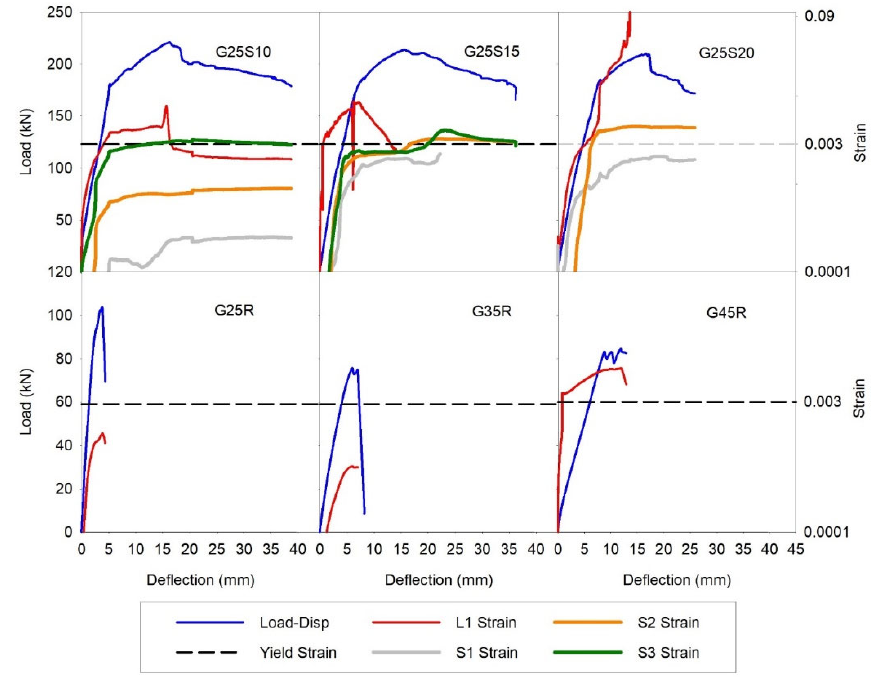
Figure 7. Load–deflection and strain–deflection curves.